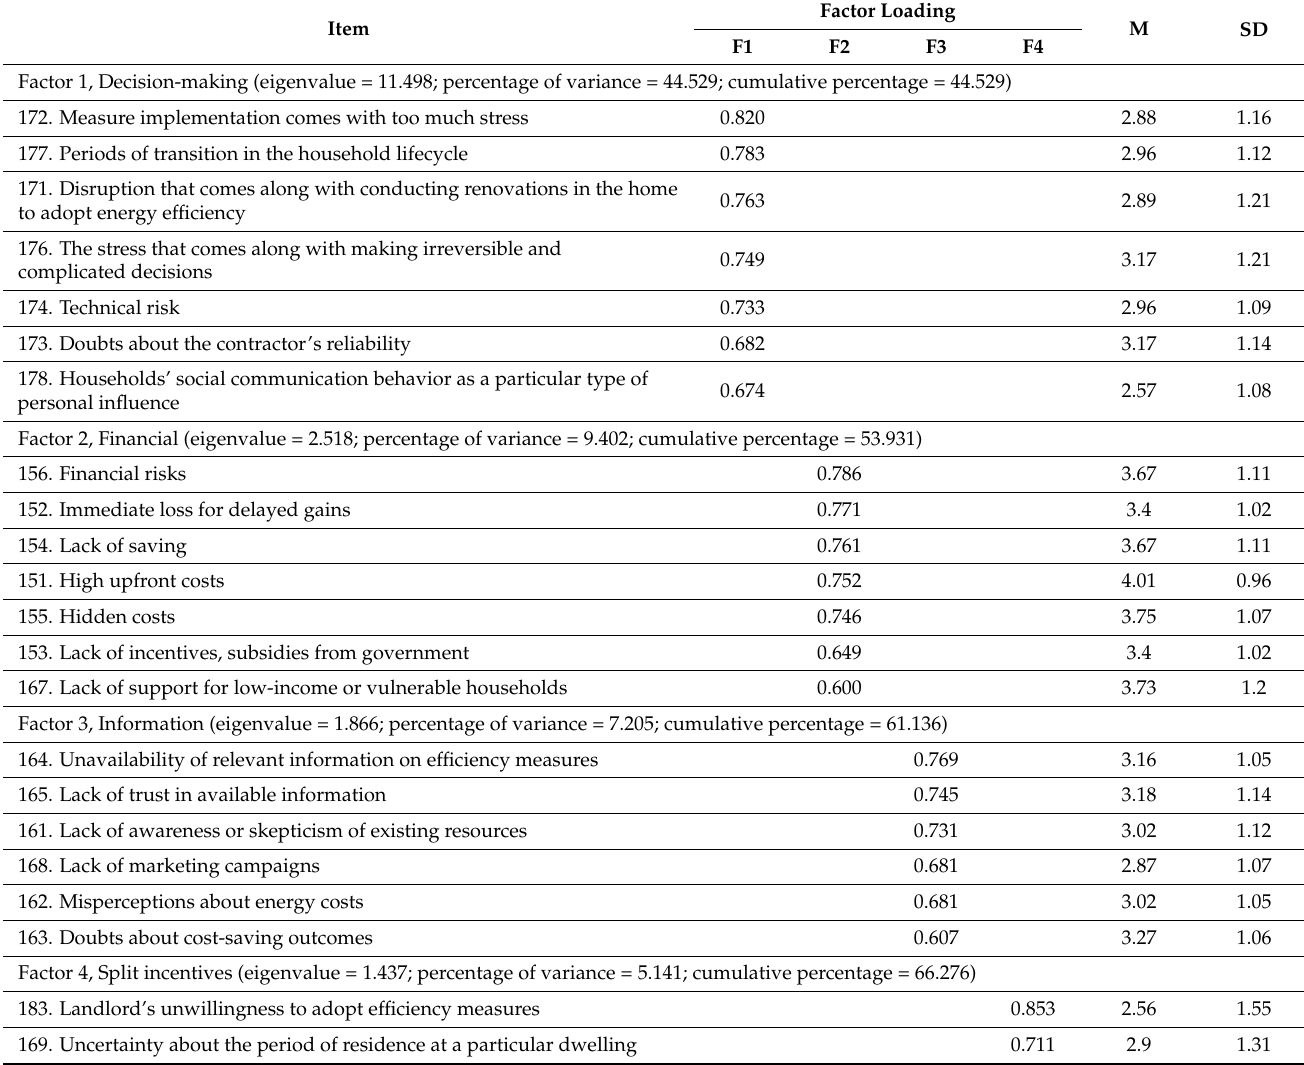
Table 3. Factor loadings based on PCA with varimax